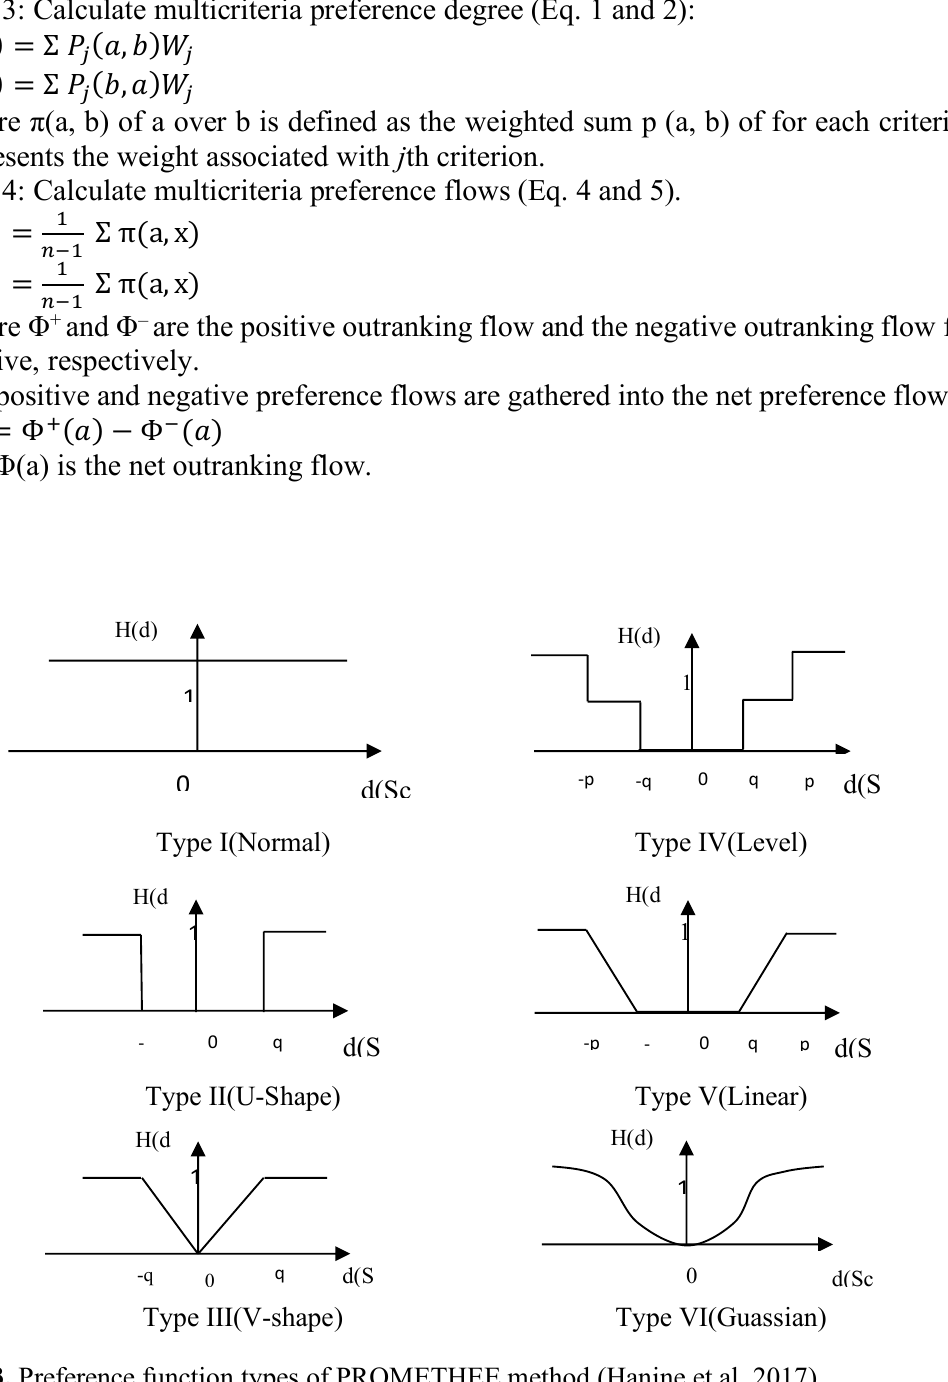
Figure 3. Preference function types of PROMETHEE method (Hanine et al.